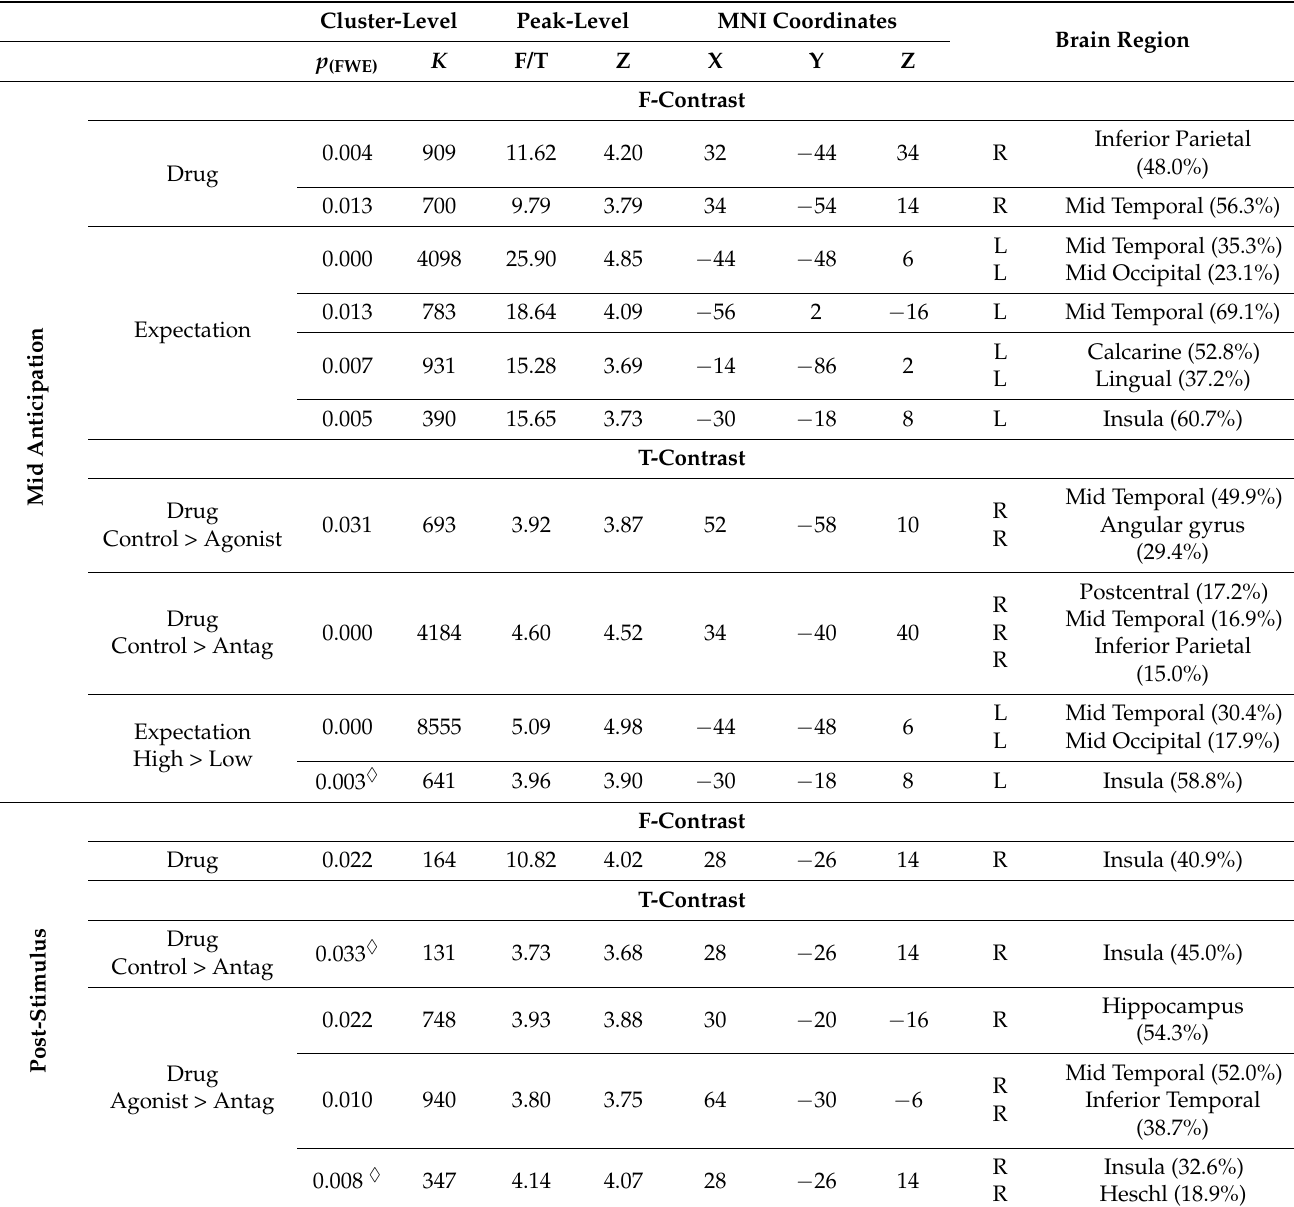
Table 3. Significant results of the source localisation analysis within mid-anticipation and the post- stimulus TWOI. The mid-anticipation TWOI is baseline-corrected to the pre-auditory cue time window. The significant clusters were restricted to >100 voxels, reported at FWE correction with a threshold of p < 0.025 to account for multiple comparisons. Results are divided into main F-contrast and post-hoc T-contrasts. The MNI coordinates are reported for the peak voxel within the cluster. The brain regions are labelled using the Anatomical Automatic Labelling (AAL2) atlas, with the percentage overlap of the significant cluster with the brain region reported. The region with the highest percentage overlap is shown, unless an equivalent share of percentage overlap was observed. Brain regions labelled by the atlas as ‘Unknown’ are not